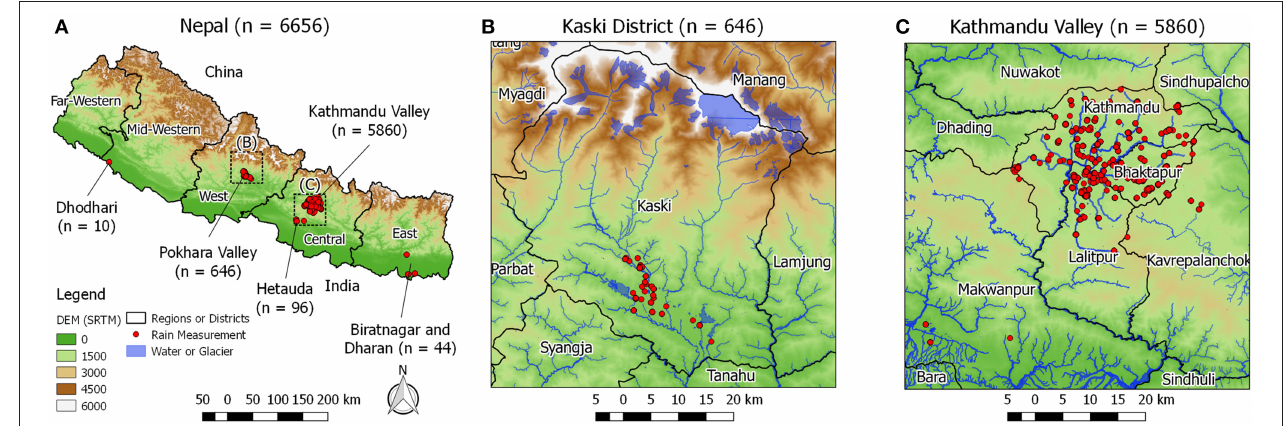
FIGURE 1 | Locations of 2018 Monsoon (May to September) precipitation measurements with the number of measurements shown in parentheses for (A) Nepal, with enlarged views of (B) the Kaski District, including the Pokhara Valley, and (C) the Kathmandu Valley. Topography shown from a Shuttle Radar Telemetry Mission